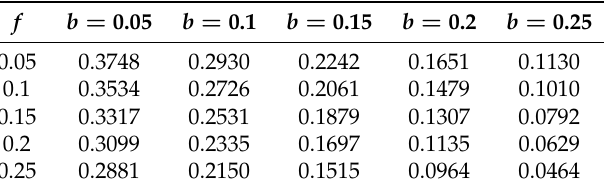
Table 8. Maximum allowable upper bounds α of Example 1.